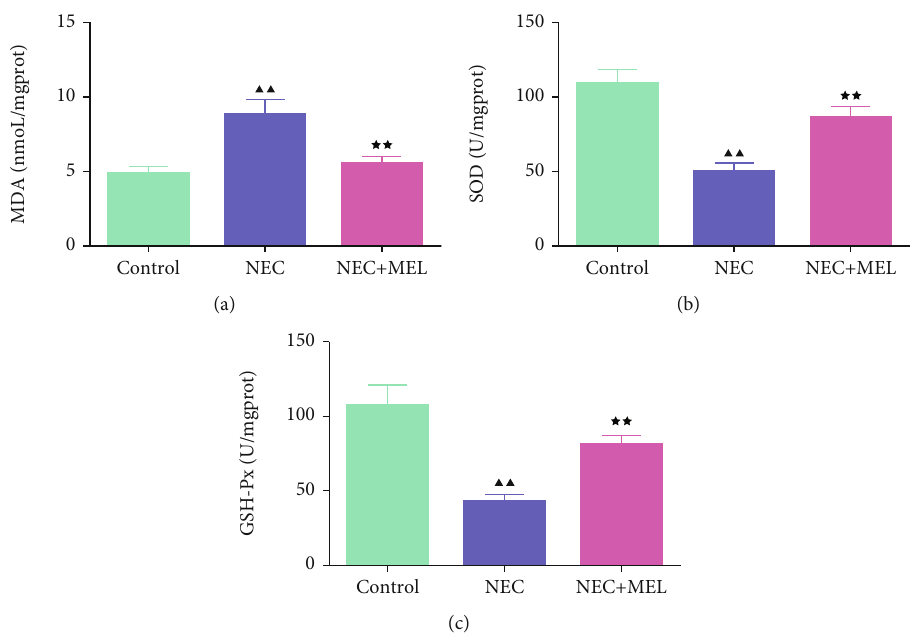
Figure 4: MEL weakened oxidative stress of serum in NEC mice. (a – c) The e ff ect of MEL on oxidative stress in NEC mice was estimated by using a kit examining the serum malondialdehyde, superoxide dismutase, and glutathione peroxidase. ▲▲ P < 0 : 01 vs. control; ★★ P < 0 : 01 vs. NEC.